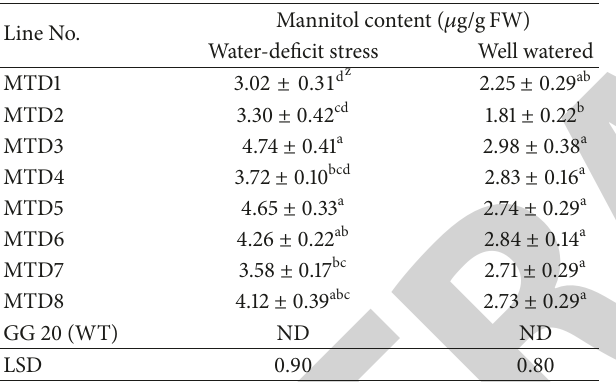
Table 2: Segregation analysis of defensin gene in selfed progenies (T Transformed groundnut lines